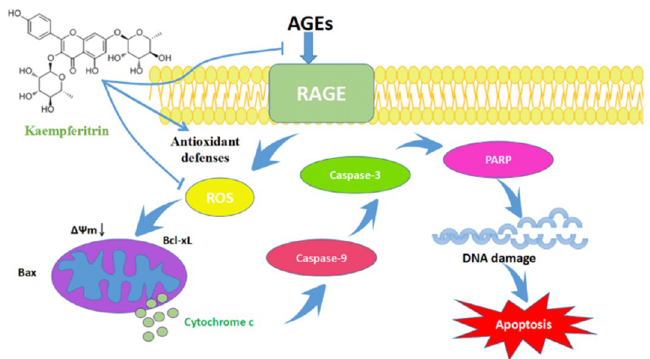
Figure 9. Schematic representation of the biological activities of KM and its effects on the AGE-induced mitochondrial/cytochrome c-mediated apoptosis pathway in GMCs. The thick blue arrows represent the order of action, the thin blue arrows represent the effects of drug intervention, the black arrow represents the decrease in mitochondrial membrane potential, the light green dots represent the release of cytochrome c in mitochondria, and the different color is for differentiate between different parts and proteins in the cell.